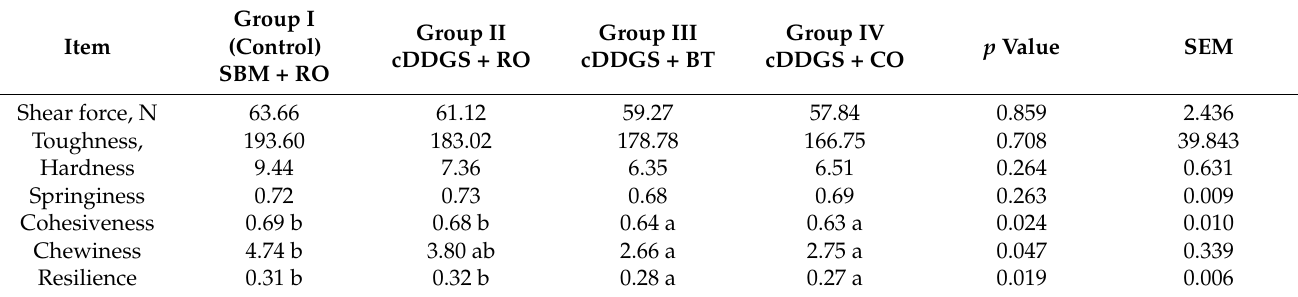
Table 4. Shear force and texture profile analysis of meat ( longissimus m.).